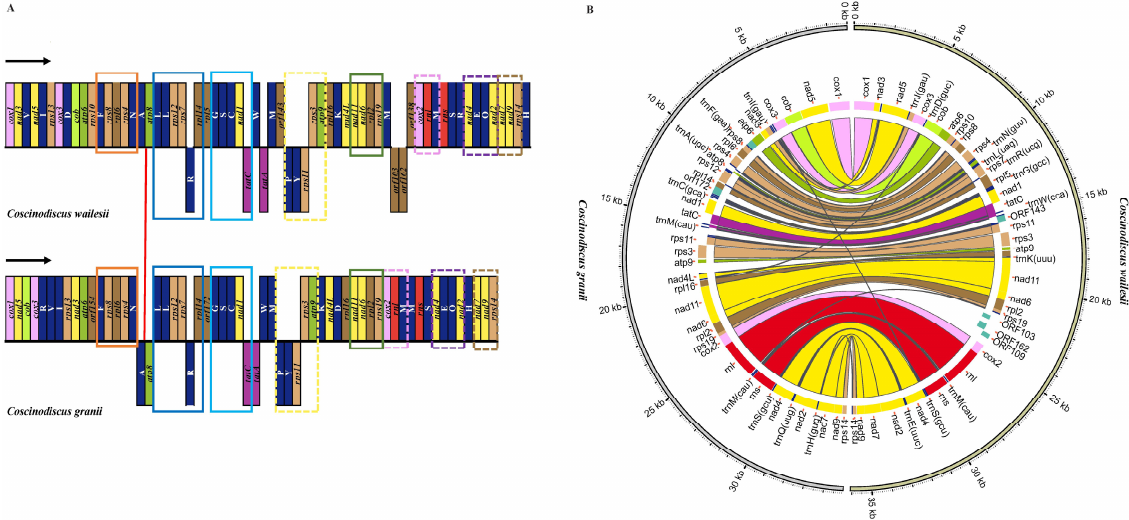
Figure 6. Synteny comparison of C. granii and C. wailesii . ( A ): Block diagram of gene content and gene rearrangement, tRNAs are indicated by capital single letter. Solid line boxes indicate the same conserved block of genes, while dotted boxes indicate translocation event and gene block connected by a red line indicates inversion event. Blocks with the same color represent the same type of genes. ( B ): The assignment of genes into different functional groups is indicated by